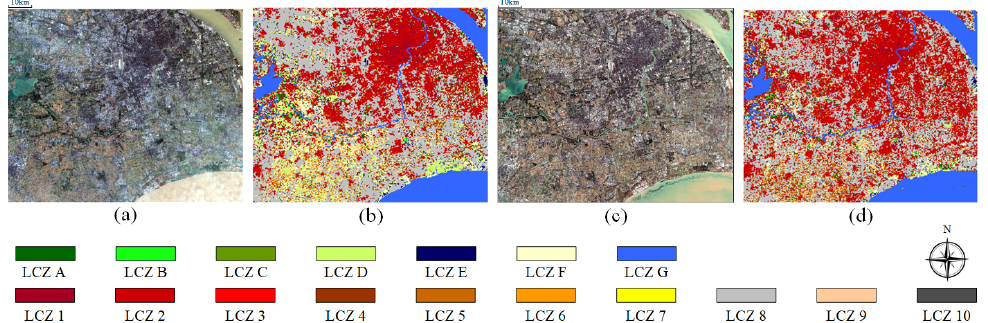
Figure 9. Changes in Shanghai, China in 6 years, where ( a , b ) are the Sentinel-2 satellite image of Shanghai in 2015 and the corresponding LCZ map, and ( c , d ) are the Sentinel-2 satellite image of Shanghai in 2021 and the corresponding LCZ map.